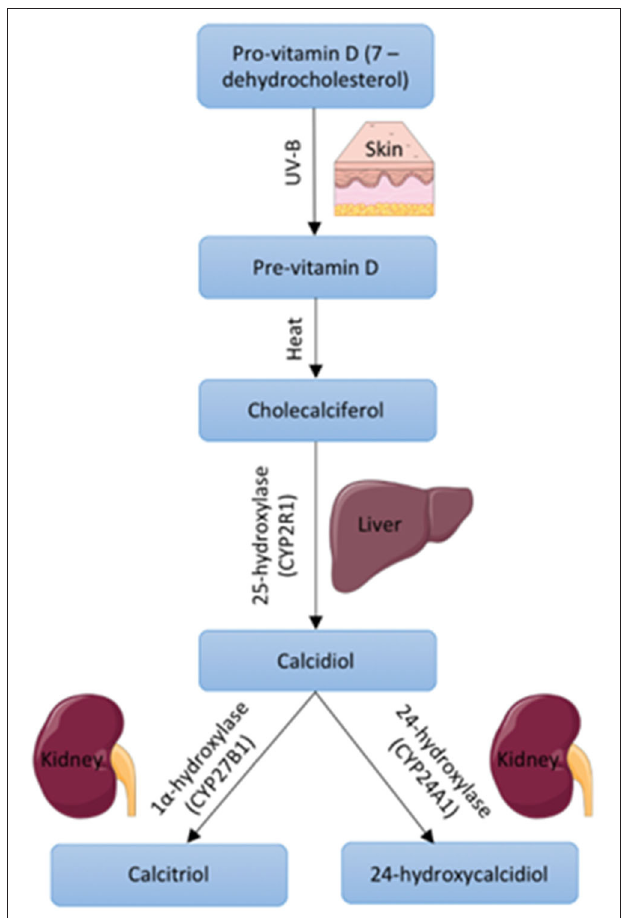
FIGURE 1 | Vitamin D synthesis within the body including precursors, enzymes, and body site. Images used within this figure were obtained from smart servier medical art and can be found at